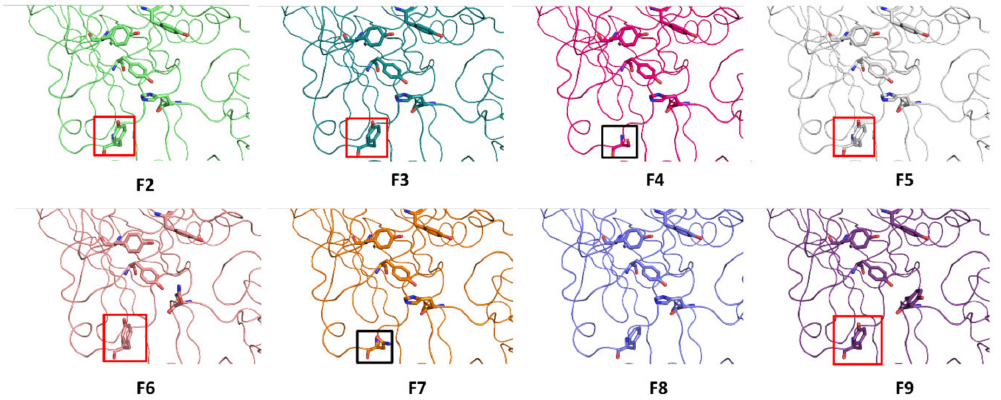
Figure 8. Structure of all subtypes of BoNT/F obtained via homology modeling, using crystal structure PDB: 3FUQ as a